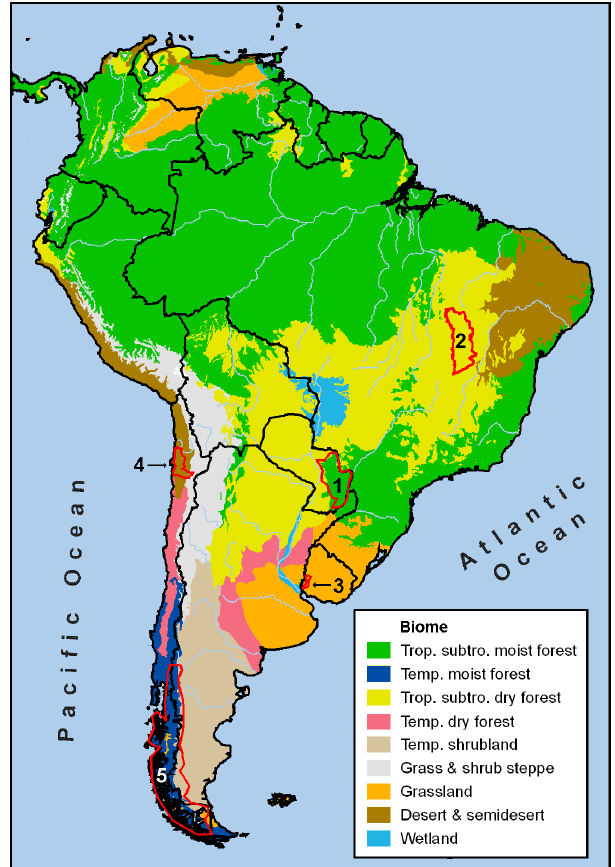
Figure 2. Localization of the five focal regions and major biomes in South America. The focal regions are: (1) Eastern Paraguay, (2) Western Bahia –Brazil, (3) Uruguay River margins – Argentina, Uruguay, (4) Northern Chilean deserts, and (5) Patagonian Andes – Argentina,